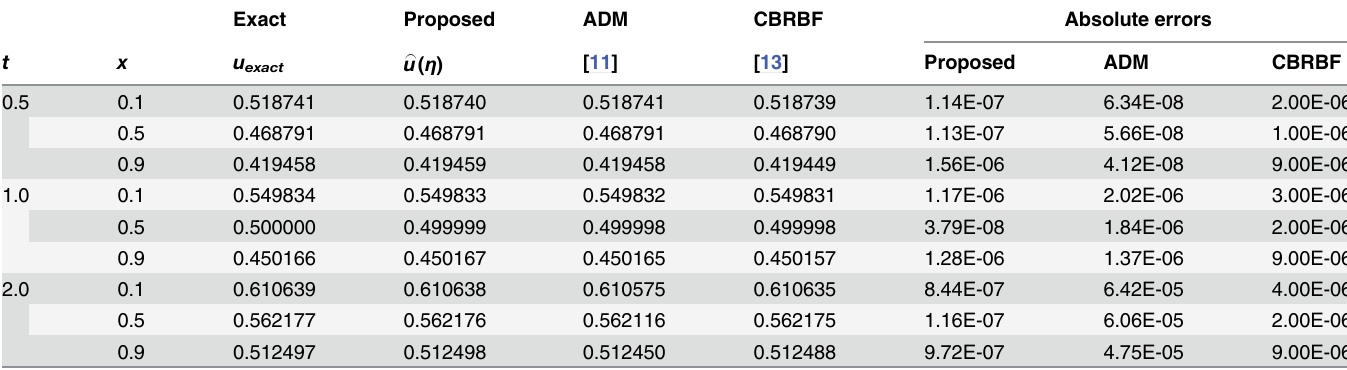
Table 10. Numerical solutions of generalized Burgers 0 equation by the proposed scheme and comparison with exact solutions, ADM [11], and RBF [13] for β = 0, α = 1, and δ = 1.